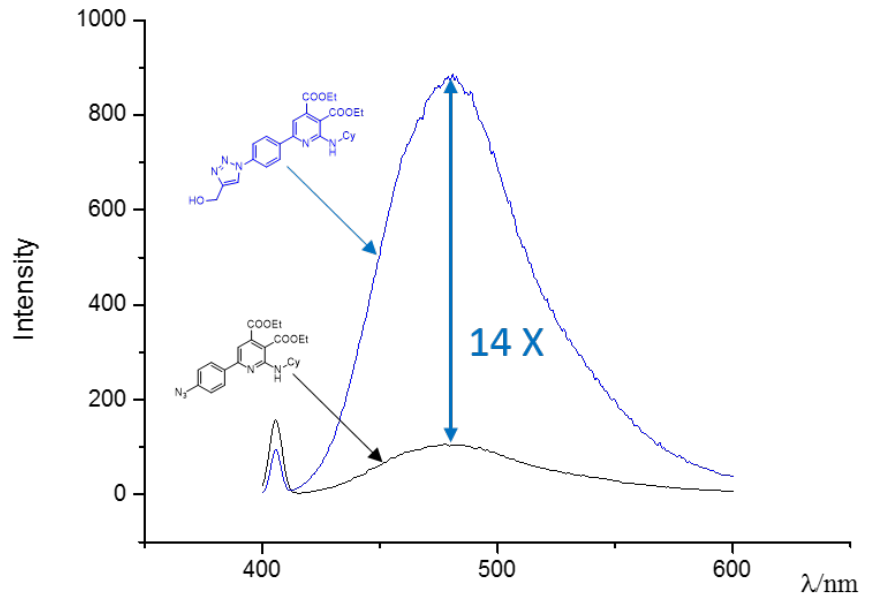
Scheme 3. Synthesis and Fluorescent Properties of Pre-fluorescence